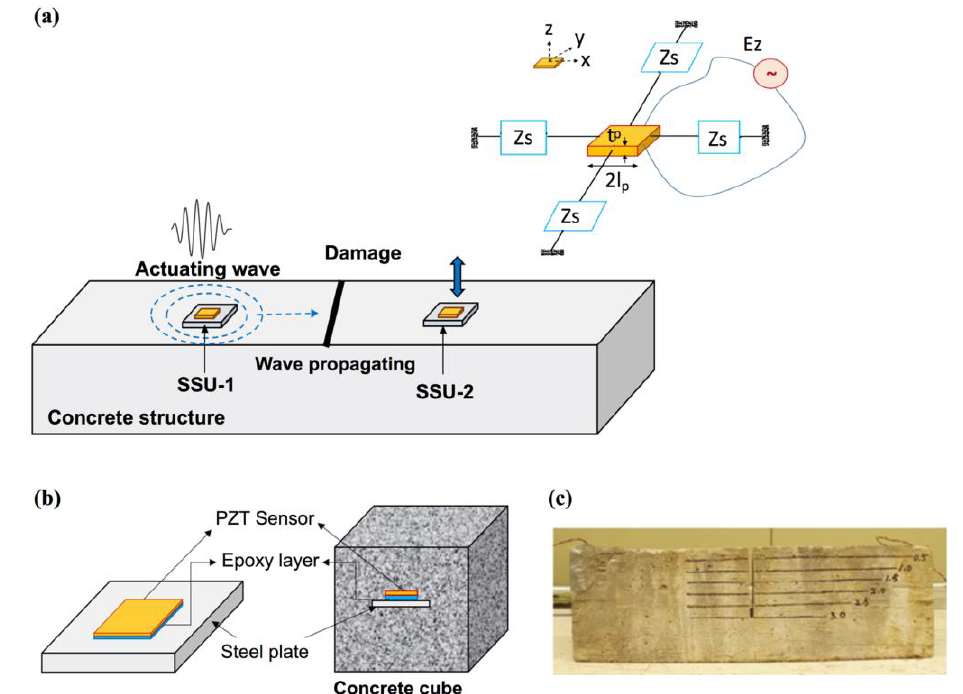
Figure 11. ( a ) Schematic representation of the combined EMI-WP technique for damage detection in concrete structure utilizing two SSUs; ( b ) the schematic diagram of concrete cube with embedded SSU and ( c ) an experimental specimen with embedded PZT patches and crack [107].